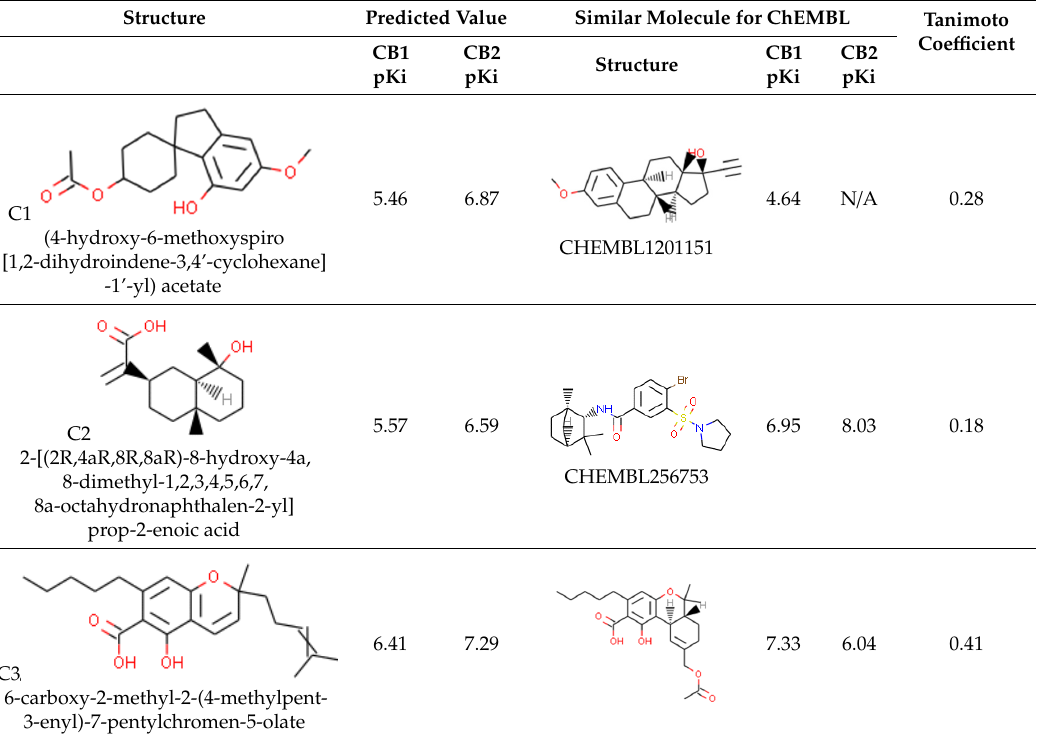
Table 1. Compounds from Cannabis Sativa that were predicted as CB2-selective and are also dissimilar to the ChEMBL training set.